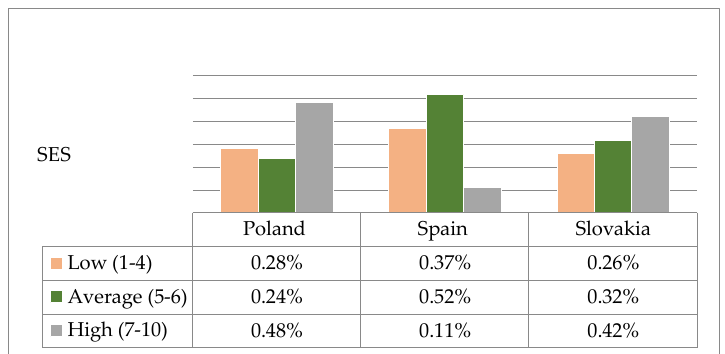
Figure 3. Structure of results of the global self-esteem according to SES on the sten scale among Polish, Spanish and Slovak students.